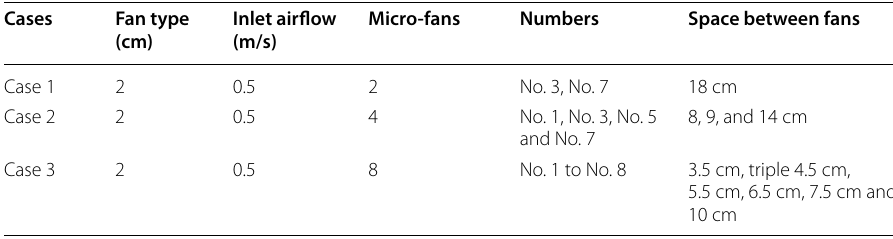
Table 2 Calculation